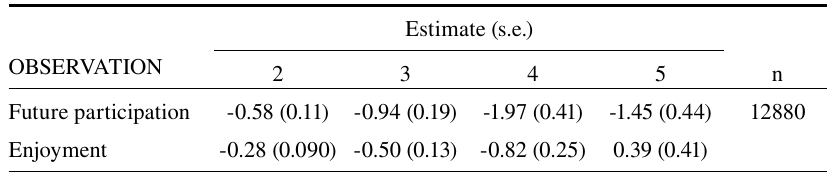
Estimates for the two interviewer observations in the full response propensity